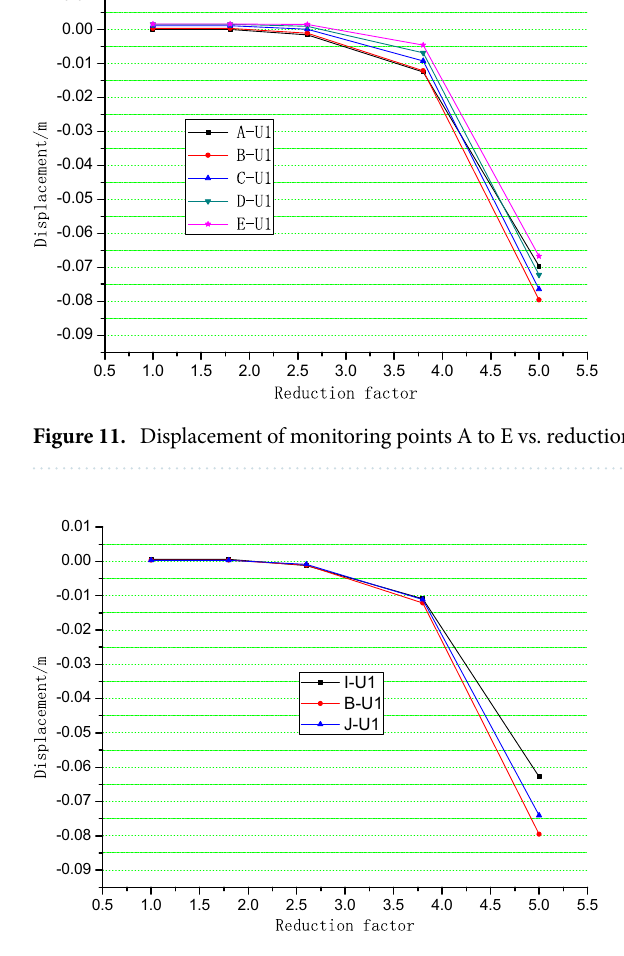
Figure 12. Displacement of monitoring points I-B-J vs. reduction factor in the x